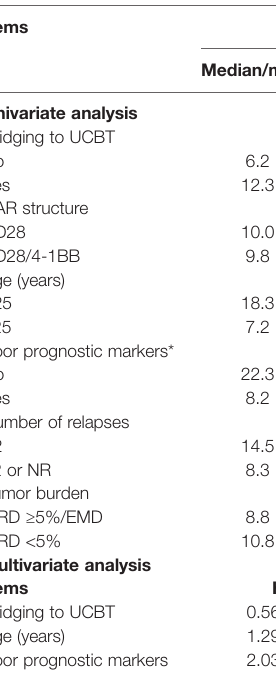
TABLE 2 | Factors affecting EFS, RFS, and OS in overall